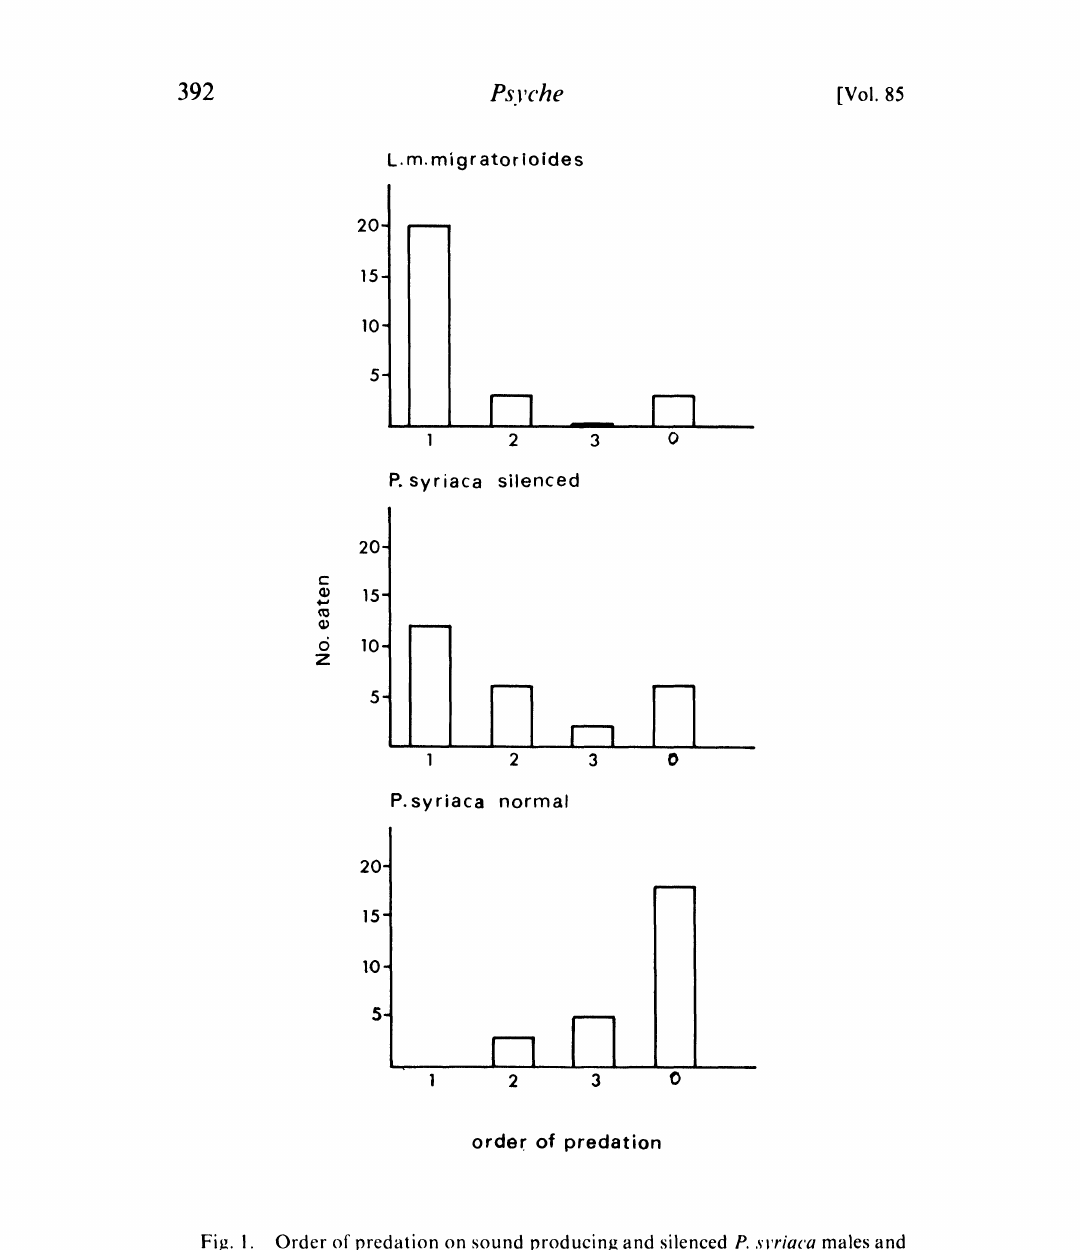
Fig. !. Order of predation on sound producing and silenced P. syriaca males and mute nymphs of L. m.